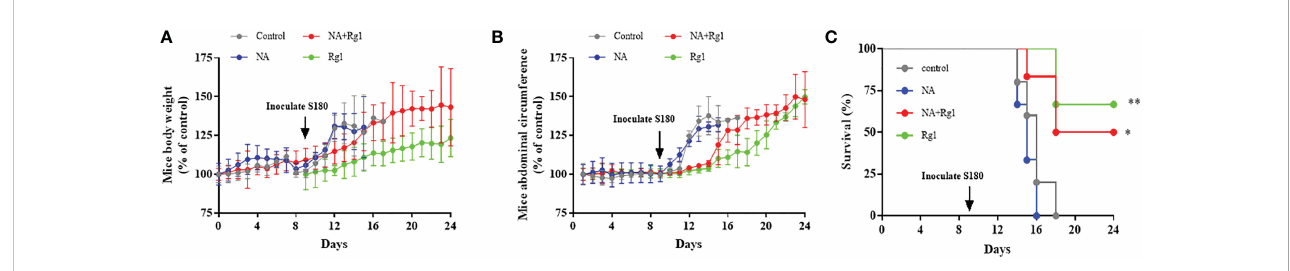
FIGURE 8 Immunoprotective effects of ginsenoside Rg1 in vivo . (A) Data of mouse body weight. (B) Data of mice abdominal circumference. (C) Data of survival rate. (n ≥ 5; log-rank test; *, P < 0.01; **, P <